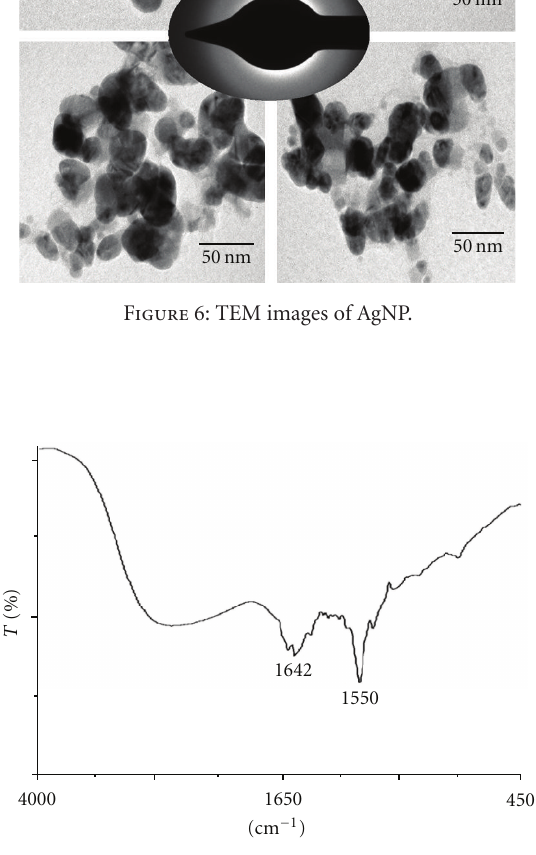
Figure 7: FTIR spectrum of